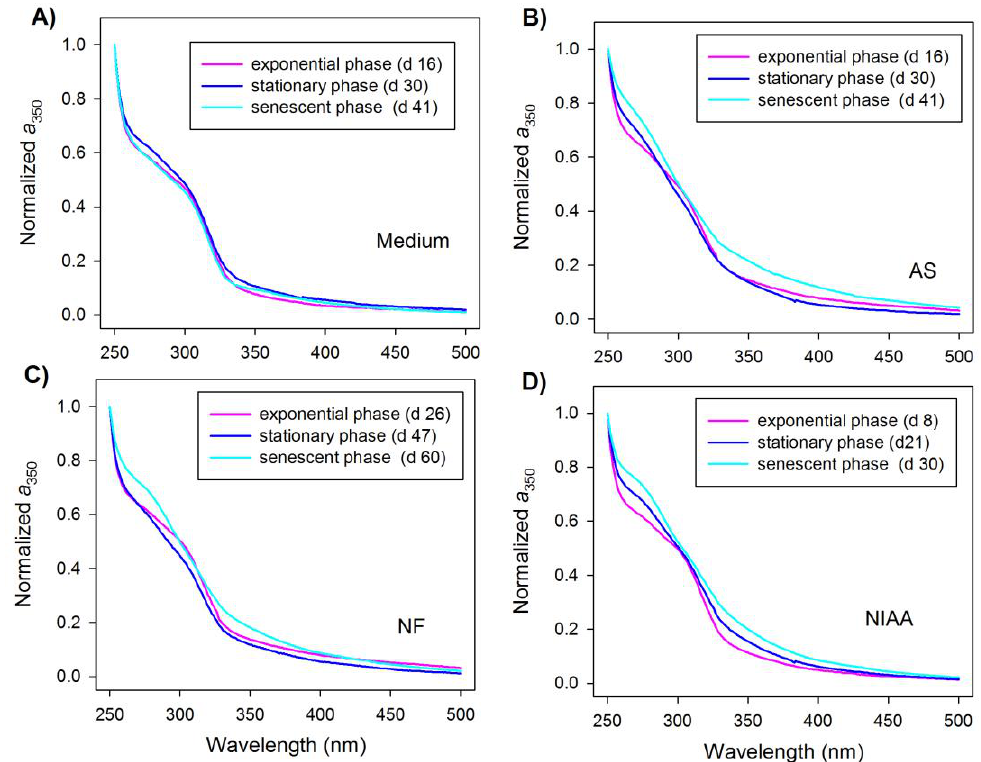
Figure 3. Evolution of the mean absorption spectrum of triplicate cultures over three different growth phases in the medium control ( A ) and the cultures ( B – D ). The spectra were normalized to the absorption coefficient at 250 nm. AS stands for Attheya septentrionalis, NF for Nitzschia frigida , and NIAA for natural ice algae assemblage.